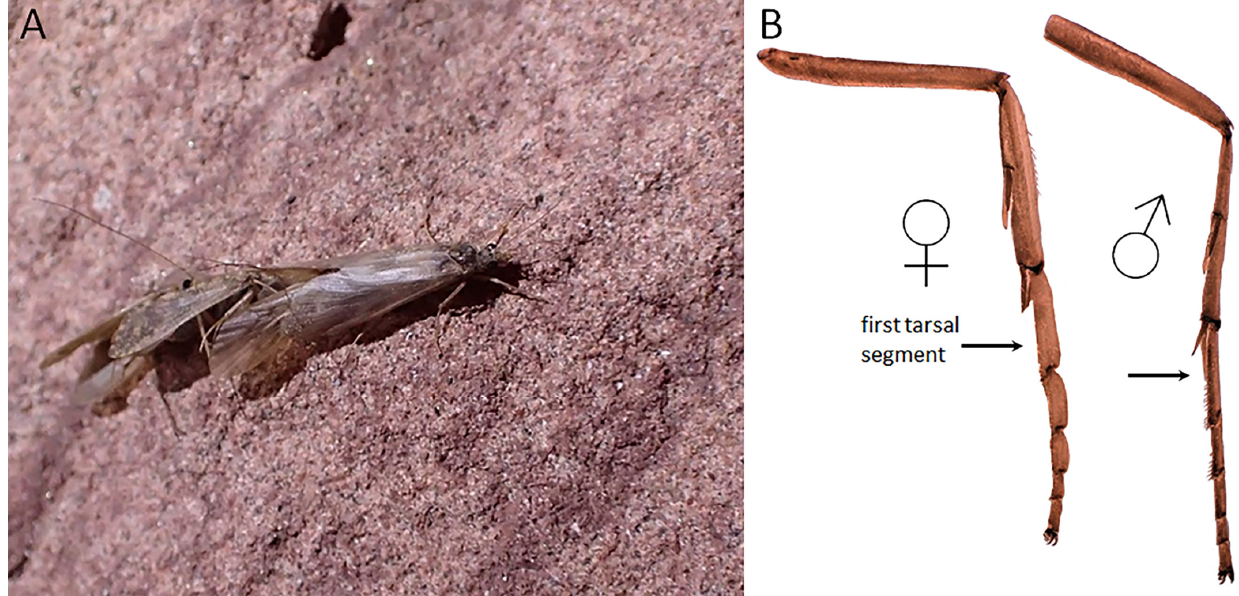
Figure 7. Hydropsyche alternans adult characteristics. ( A ) Mating behavior, a female (center right) being examined by a male (under her wing); ( B ) female and male mesothoracic legs showing sexual dimorphism, widened female middle legs are a common feature hydropsychid females that dive and swim to oviposition sites.